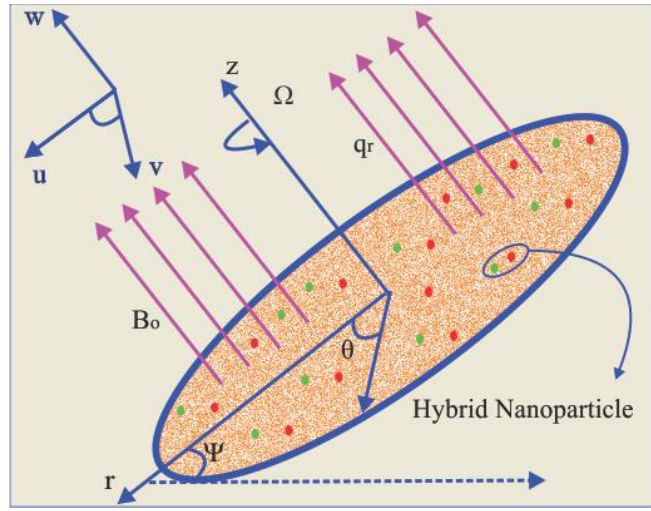
Figure 1. The geometry of the physical problem.